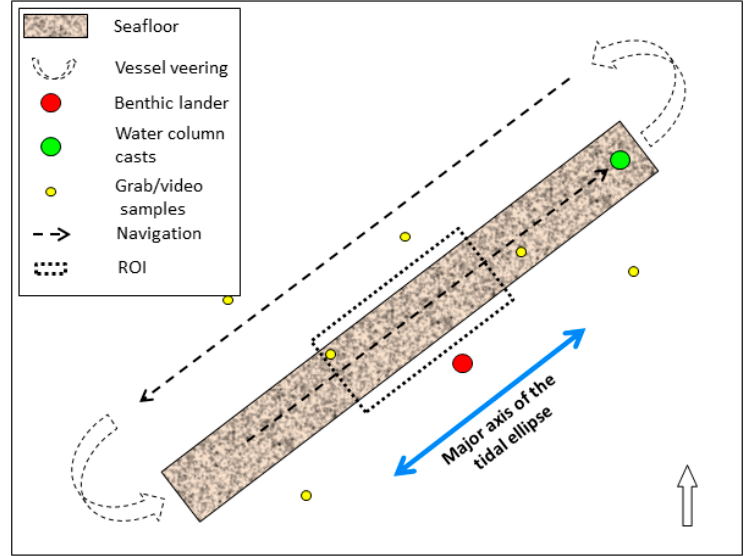
Figure 2. Schematic representation (not to scale) of the surveying principle designed to capture the short-term backscatter variability over a homogeneous region of interest (ROI). See main text for